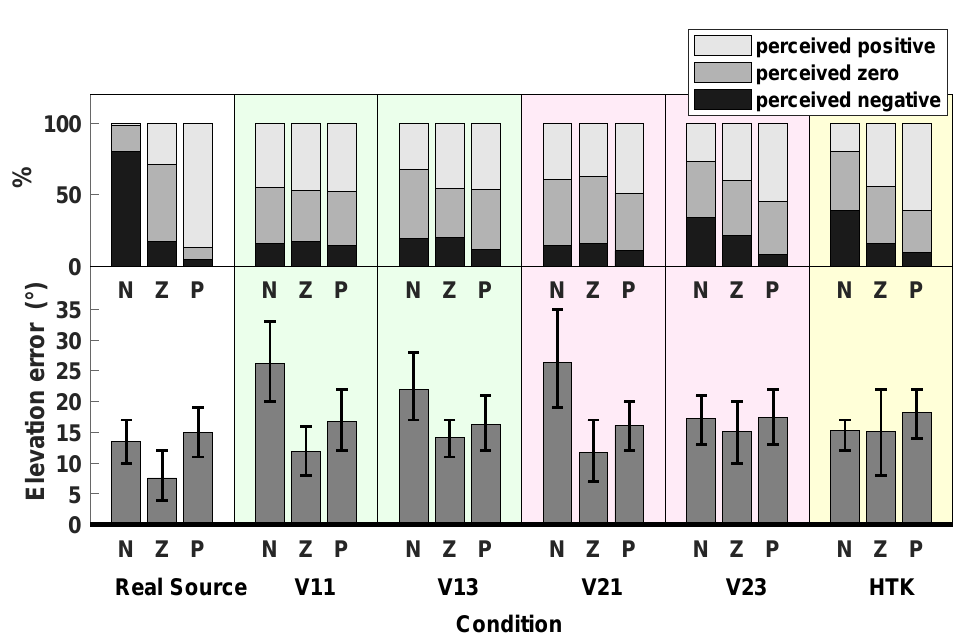
Figure 7. Average elevation error, when localizing real sources in TestReal (Real Source) and virtual sources in TestVR (generated with V11,V13, V21, V23 and HTK). ( Bottom ) Absolute error, averaged over 14 subjects for negative (N), zero (Z) and positive (P) target elevations. Error bars indicate 95% confidence intervals. ( Top ) Percentages of response elevations, which were perceived as negative (below − 5 ◦ ), zero (between − 5 ◦ and + 5 ◦ ) or positive (above + 5 ◦